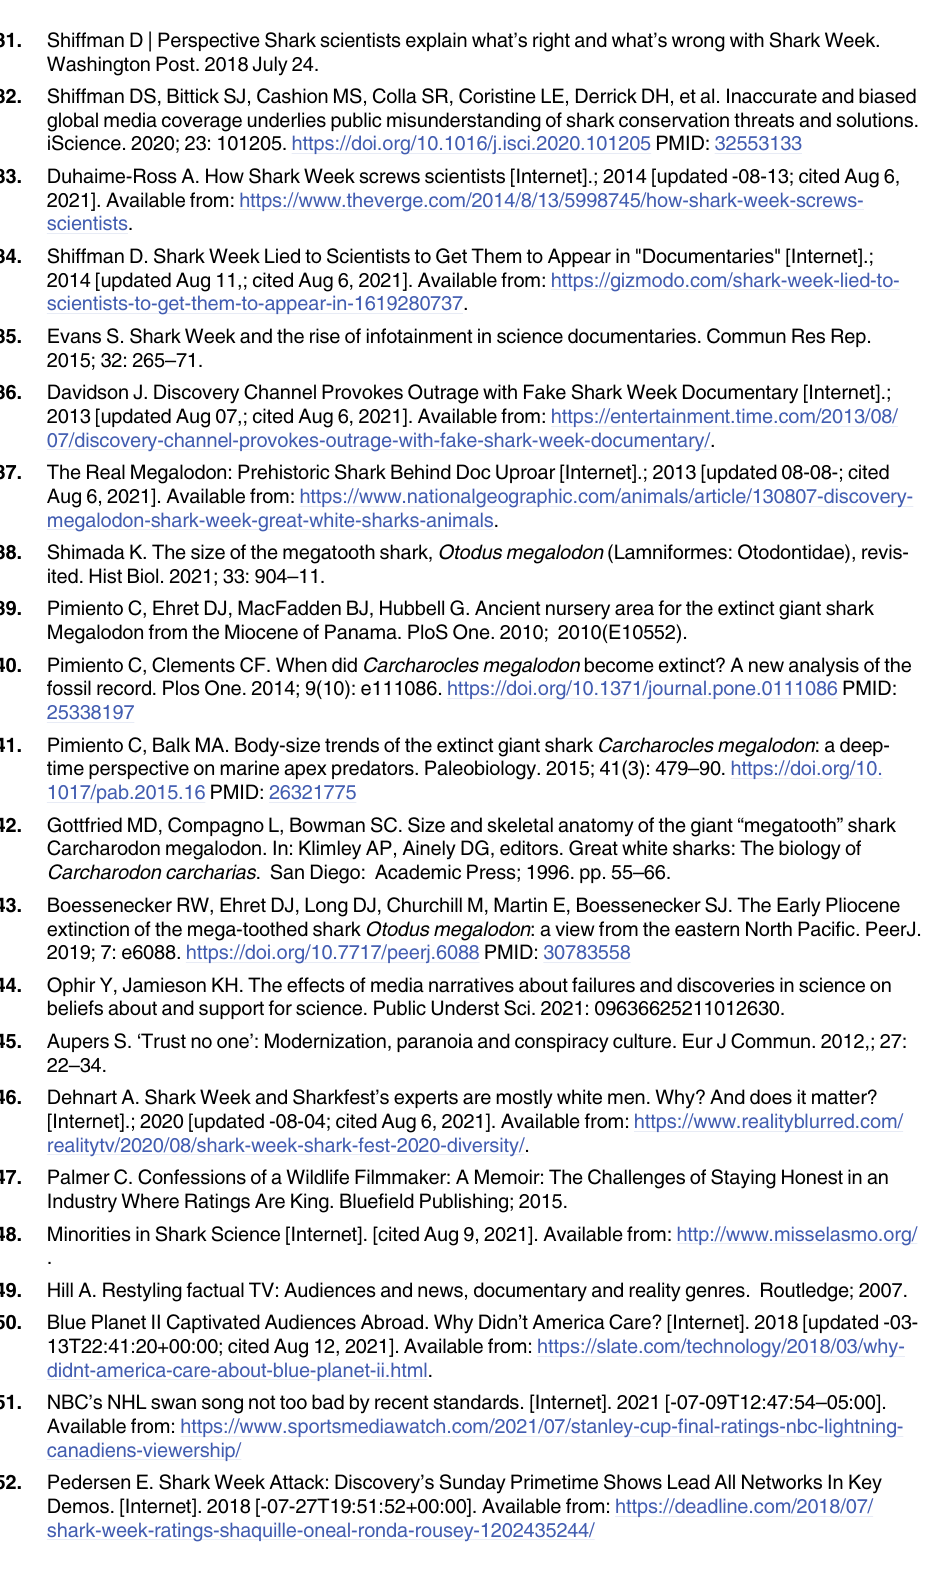
52. PedersenE. Shark Week Attack: Discovery’s SundayPrimetime Shows LeadAll Networks In Key Demos. [Internet]. 2018 [-07-27T19:51:52+00:00]. Available from: https://deadline.com/2018/07/